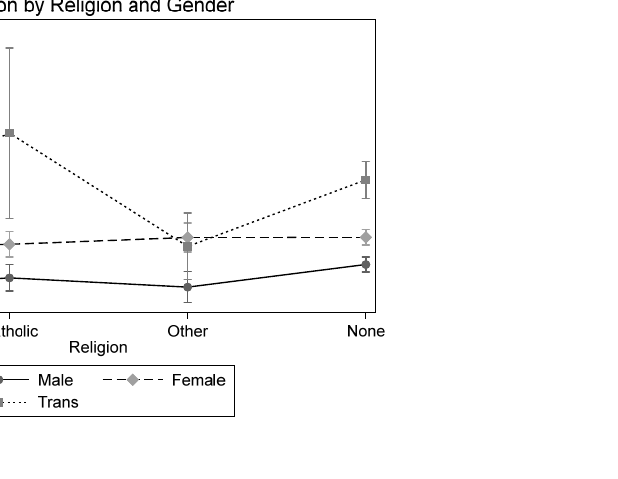
Figure 1. Significant interactions between religion, sexual orientation, and gender identity. (n = 46,562). Note. Differences noted are statistically significant differences (at least p < 0.05). Bonferroni correction factor used for analyses.